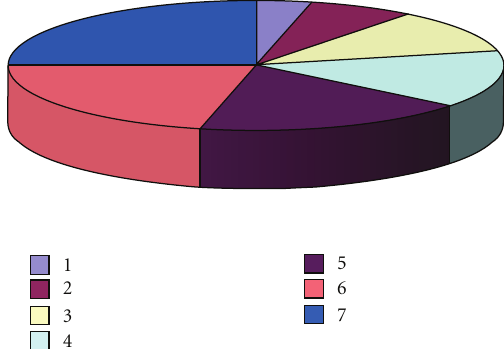
Figure 1: The relative shares of the most commonly used explants for initiation of Rhodiola in vitro cultures. Explant were excised from plants growing in their natural environment: (1) leaves, (2) stem, (3) shoot tips and buds, (4) nodes and rhizome buds, (5) axillary buds, (6) hypocotyl, and (7) apical buds and stem nodes from in vitro seedlings.